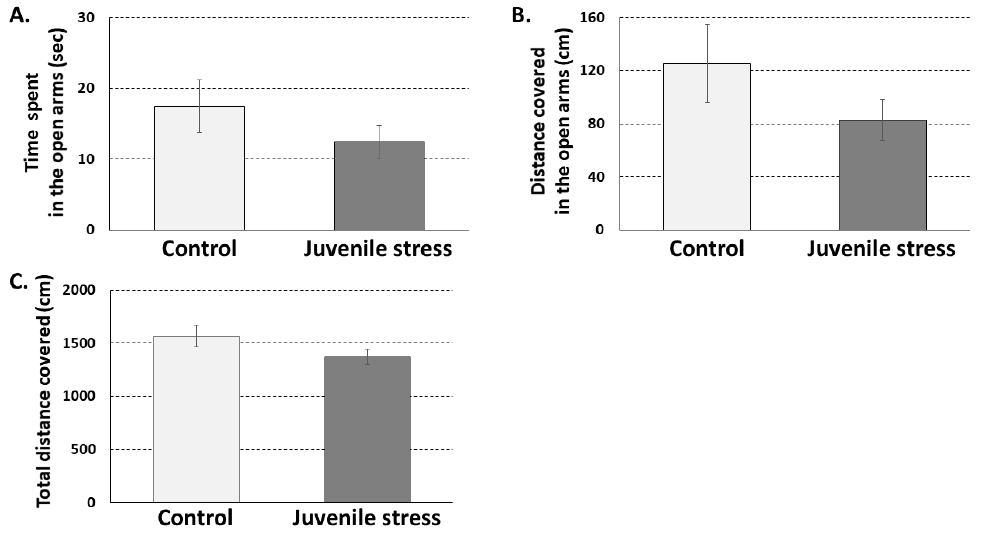
Figure 1. Rat behavior in the elevated plus maze (EPM) 28 days following exposure to juvenile stress: No significant differences were observed between control ( n = 28) and juvenile stress exposed rats ( n = 28) in the amount of time spent ( A ) and in activity levels ( B ) in the open arms of the EPM. In addition, no significant difference was observed between the groups in total activity levels in the EPM arena ( C ).